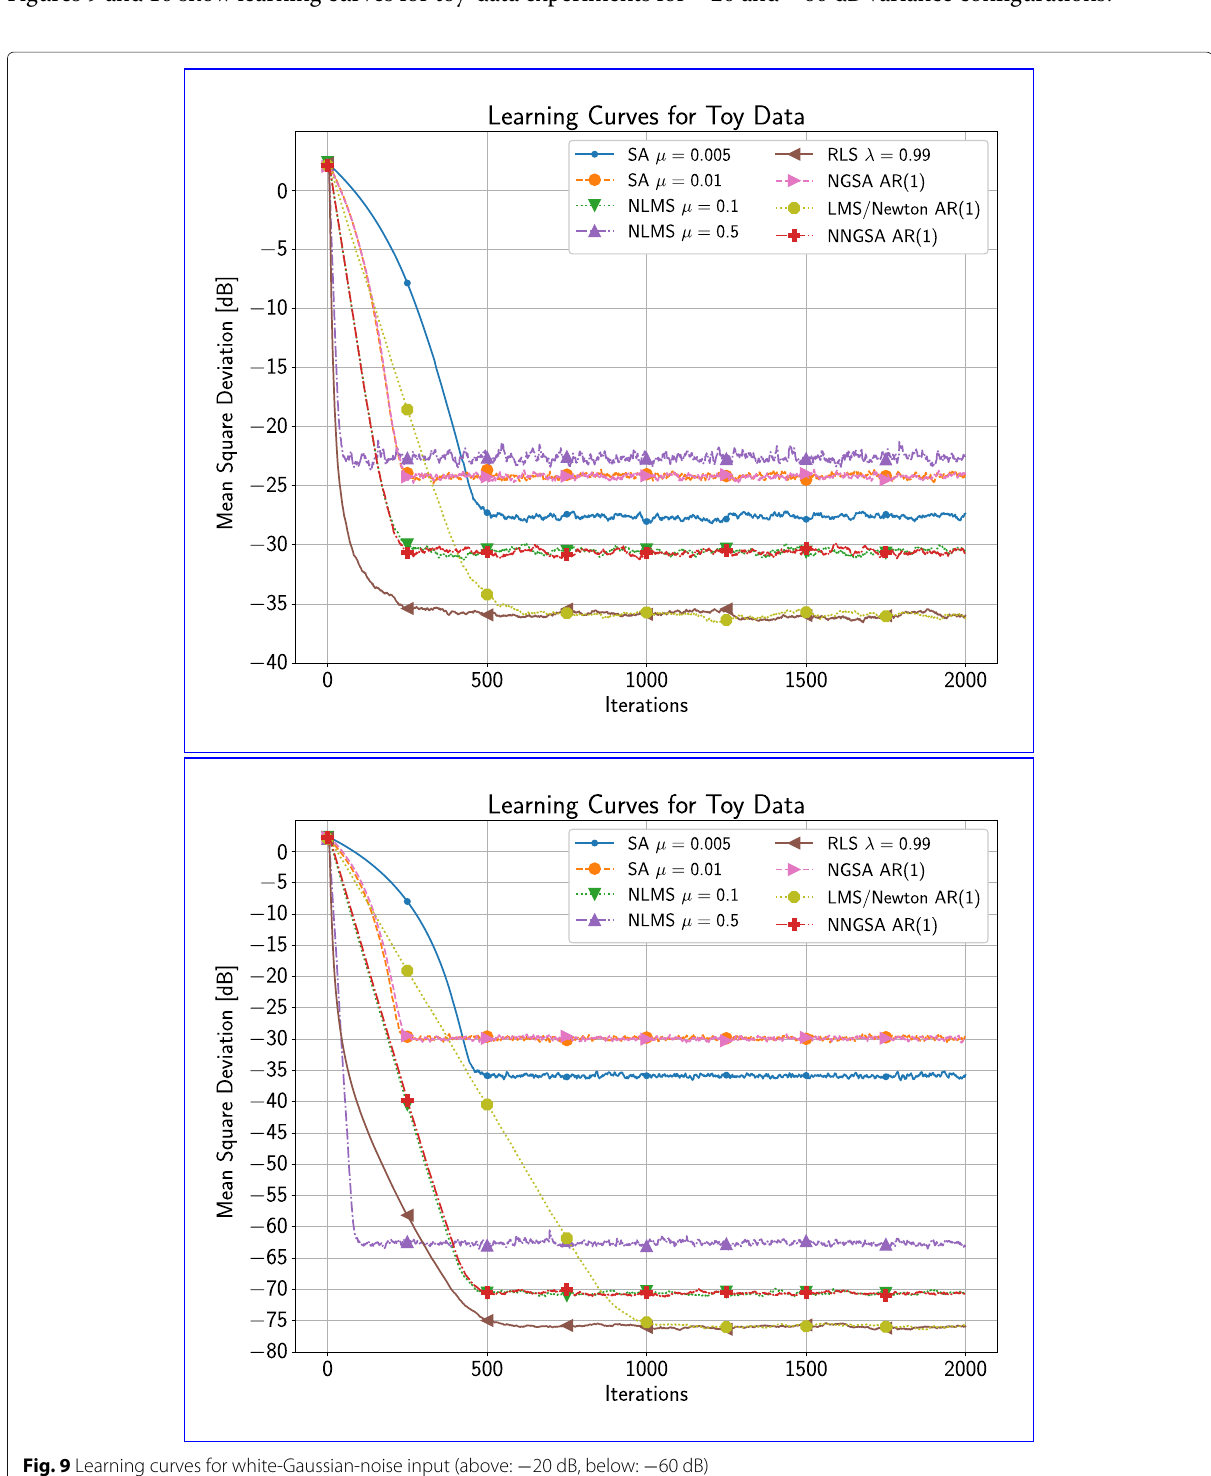
Fig. 9 Learning curves for white-Gaussian-noise input (above: − 20 dB, below: − 60